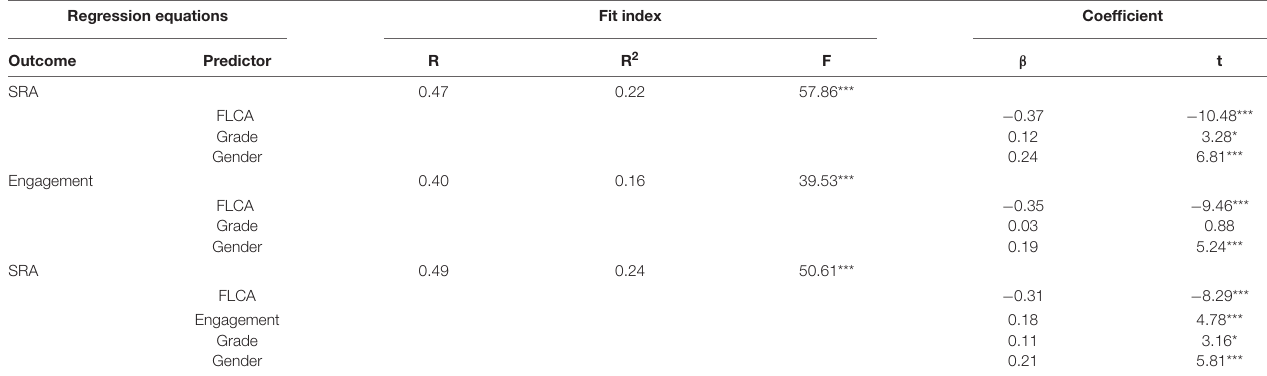
TABLE 5 | Regression results of model 2.